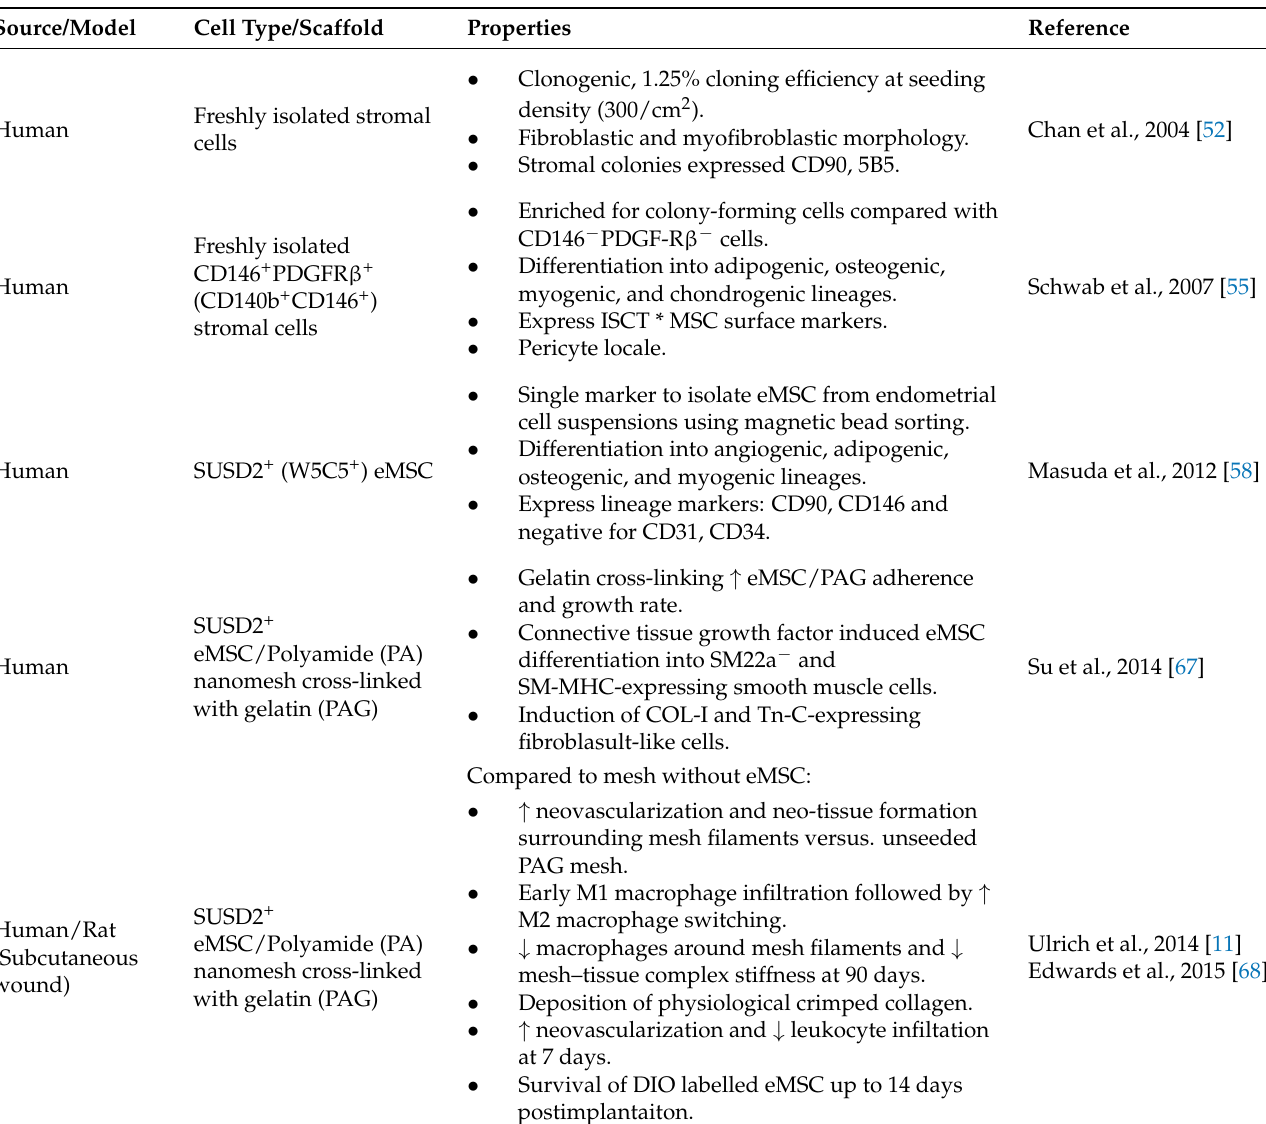
Table 1. Summary of endometrial MSC (eMSC)/stromal cell discoveries combined with novel tissue engineered scaffolds for applications in pelvic organ prolapse